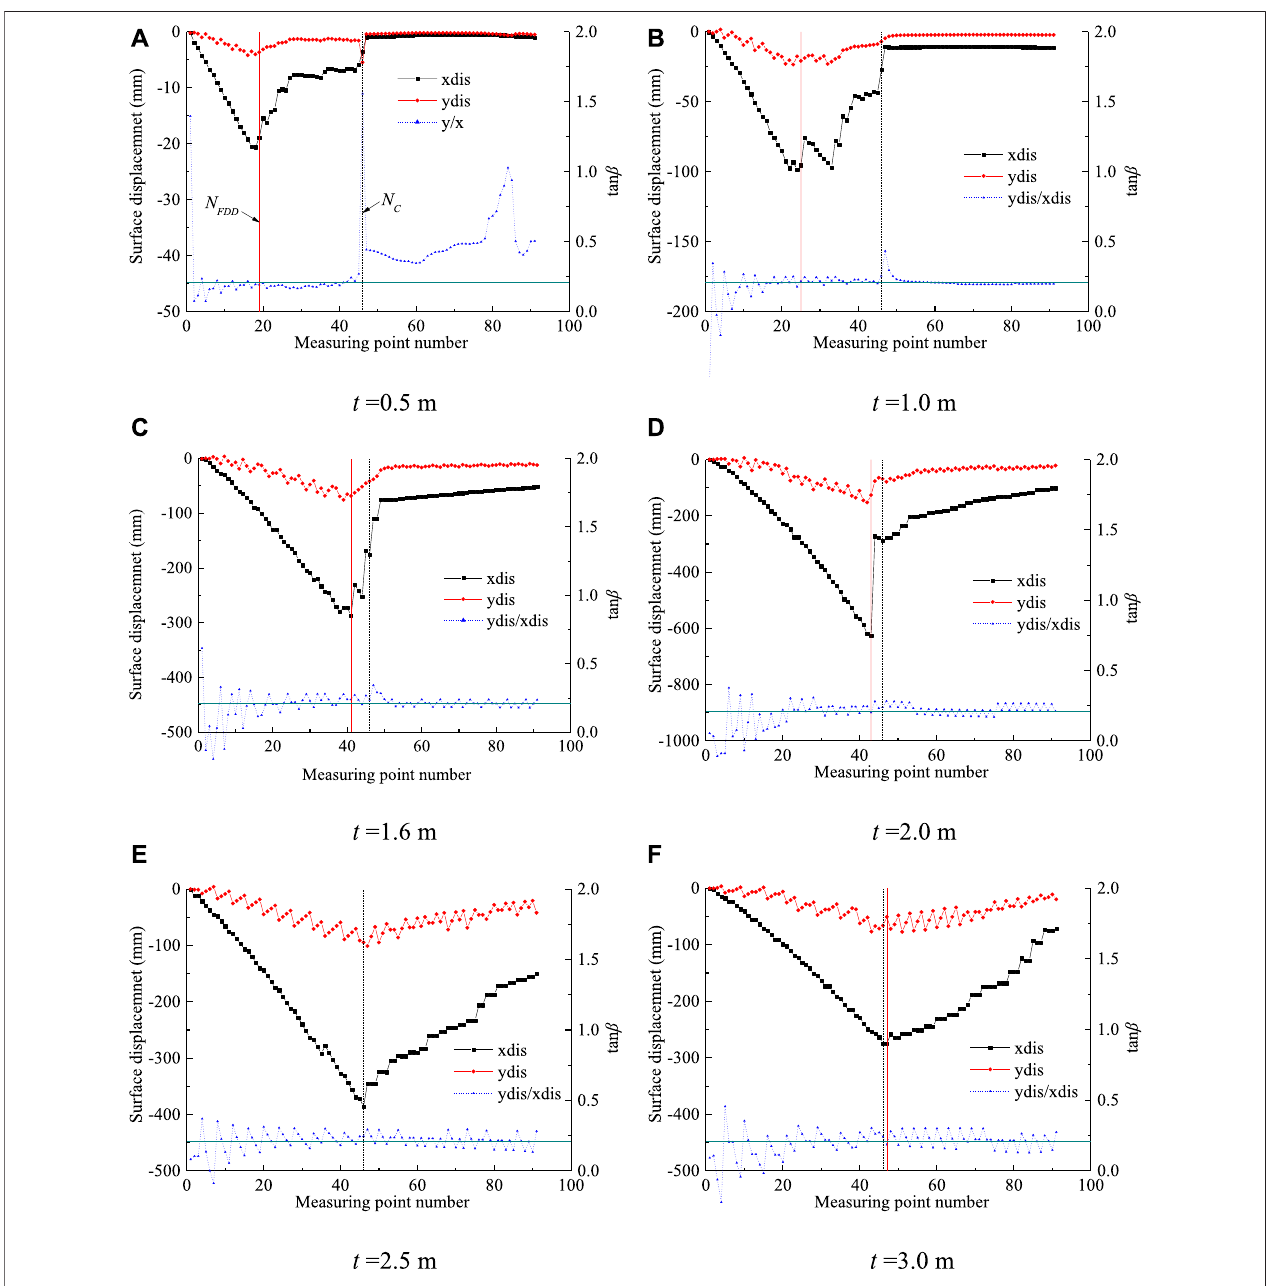
FIGURE 7 | Surface displacement distribution of slope for different joint spacing ( t ). N C and N FDD : Measuring points corresponding to the slope crest and fi rst displacement discontinuity, respectively.